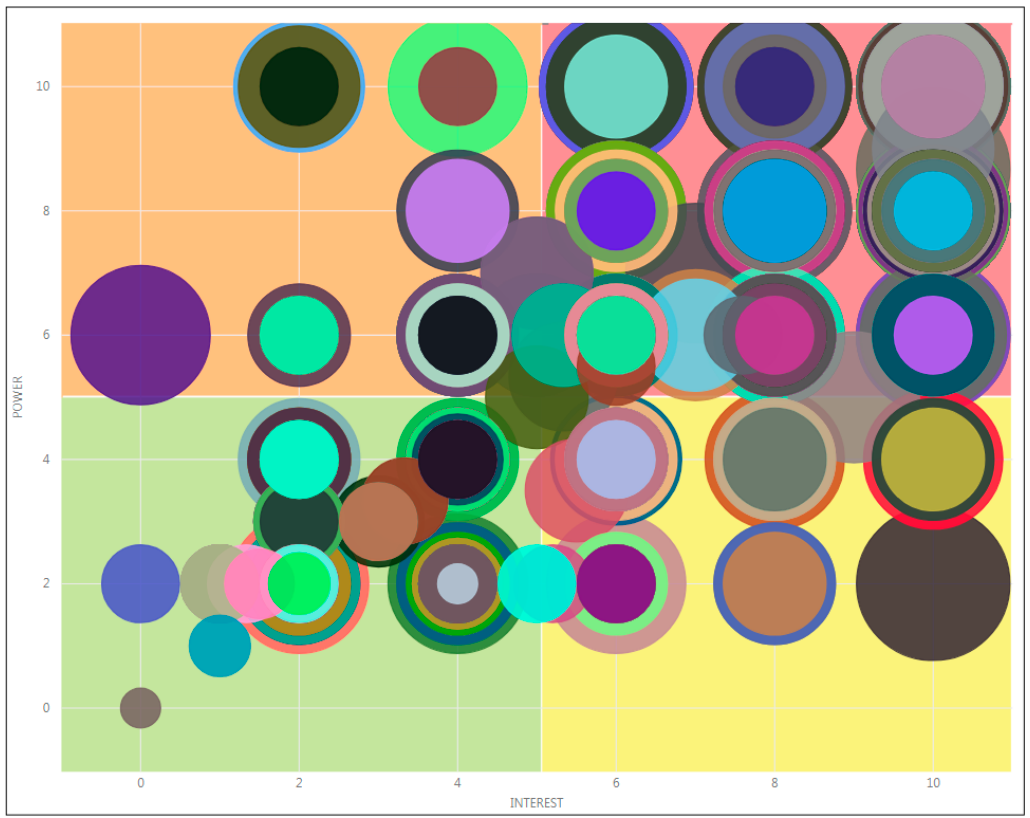
Figure 10. Representation of the power–interest–impact matrix of the set of stakeholders analyzed in the 13 projects.